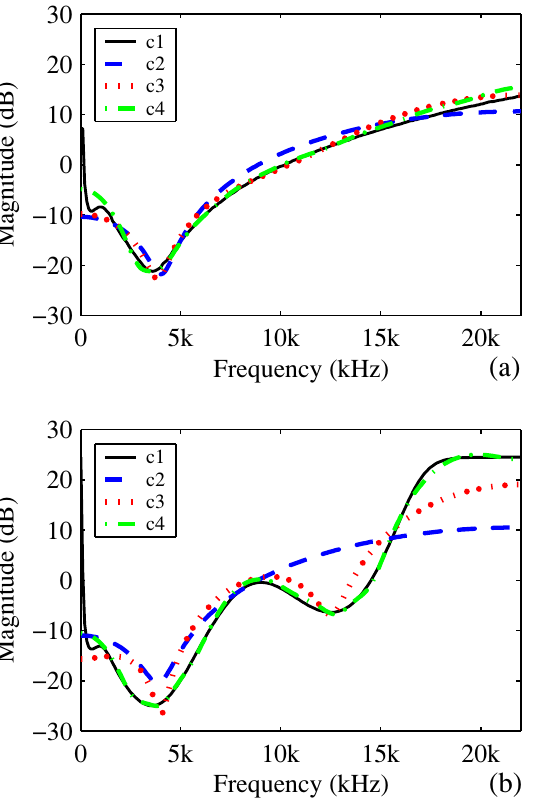
Figure 5. The target curves (c1) – modified E (a), and modified F (b), and PSDs of the filters of 2 nd (c2), 5 th (c3) and 15 th (c4) order designed by the improved procedure I using new modified E (a), and new modified F curve (b).